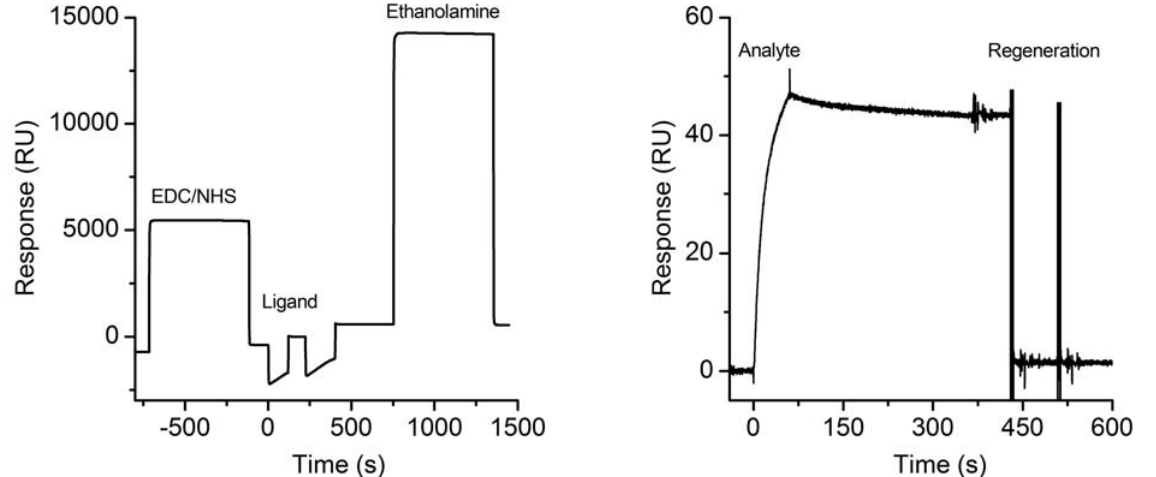
Figure 3. A typical SPR experiment. The left panel shows immobilization of one of the binding partners (ligand) to the surface of the sensor chip. The whole procedure is done through injecting solutions across the sensor chip. At the end of the process the ligand is covalently attached to the sur- face of the sensor chip, which is visible as the increase of the signal over the baseline value (compare starting signal level with the signal at the end). Right panel shows the typical experiment in which the second interacting molecule (analyte) is injected across the ligand. After the dissociation step, the regeneration procedure prepares the sensor chip surface for the next cycle. EDC, 1-ethyl-3-(3-dimethylaminopropyl)carbodiimide hydrochloride; NHS,